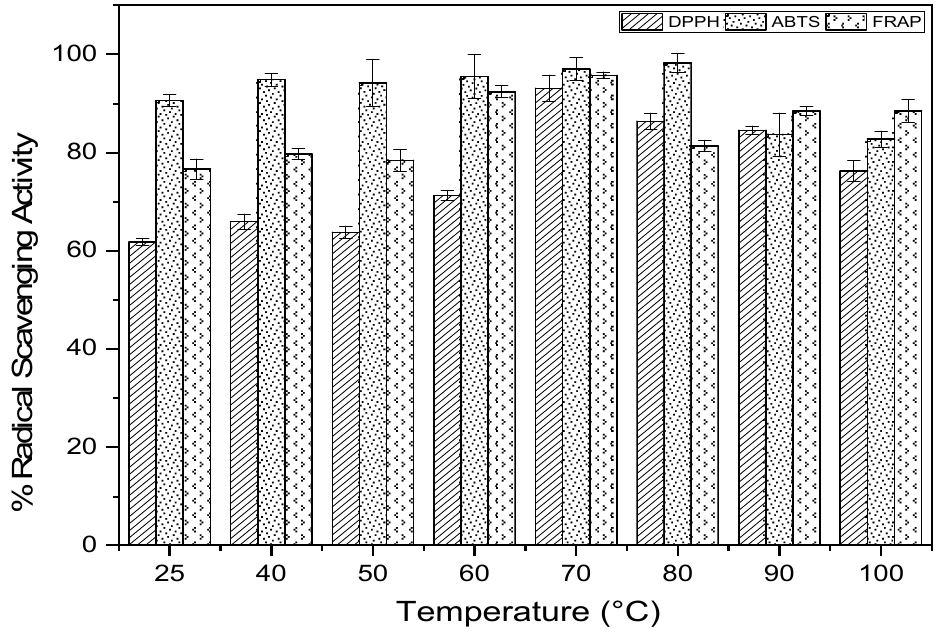
Figure 5. Antioxidant activity determined by DPPH, ABTS and FRAP assay from different temper- atures.